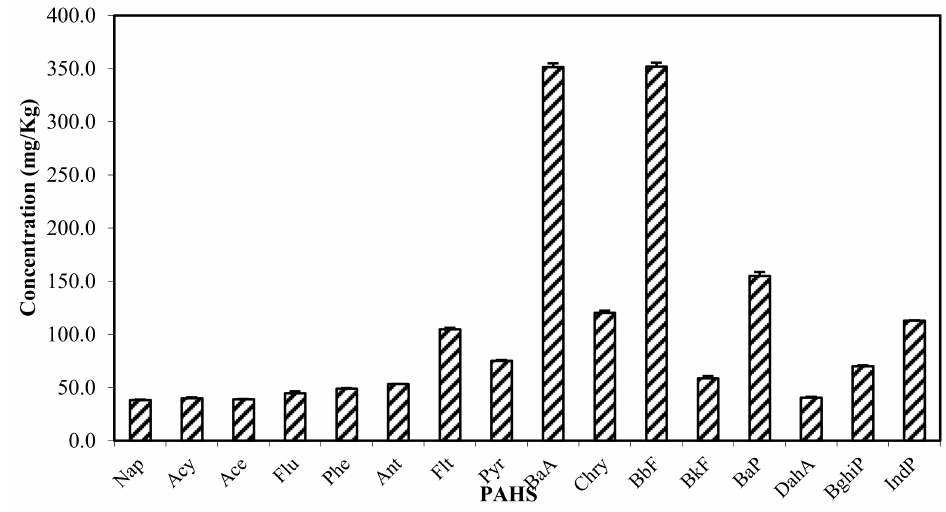
Figure 2. Individual PAHs levels in the sediments of the study area. Table 2. Descriptive statistics, ER-L and ER-M values of PAHs contents in the sediment of the area studied (in